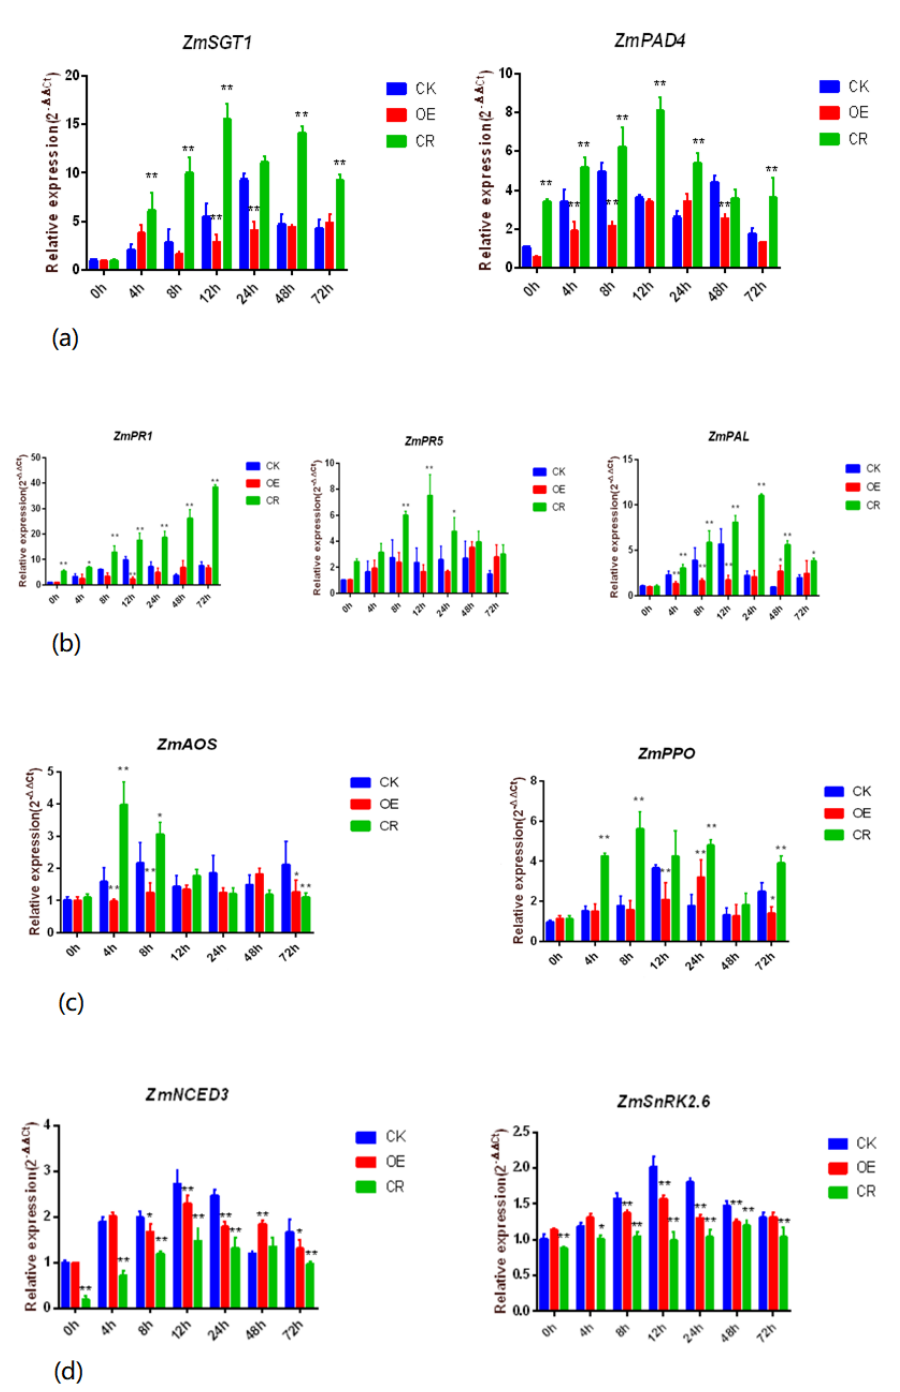
Figure 4. ( a ) R -gene-related gene expression changes, * means significant difference compared with the control ( p ≤ 0.05) ** means extremely significant difference compared with the control ( p ≤ 0.01); ( b ) changes in the expression of salicylic−acid−related genes . ( c ) Jasmonate-related gene expression changes. ( d ) Abscisic-acid-related gene expression. CK: control plants; OE: transgenic plants over- expressing the ZmBON3 gene; CR: ZmBON3 − gene − edited plants. All of the materials are from three-leaf plants. Each set of data was taken from the mean value of relative expression and statistically analyzed. Similar results were obtained in three separate experiments.